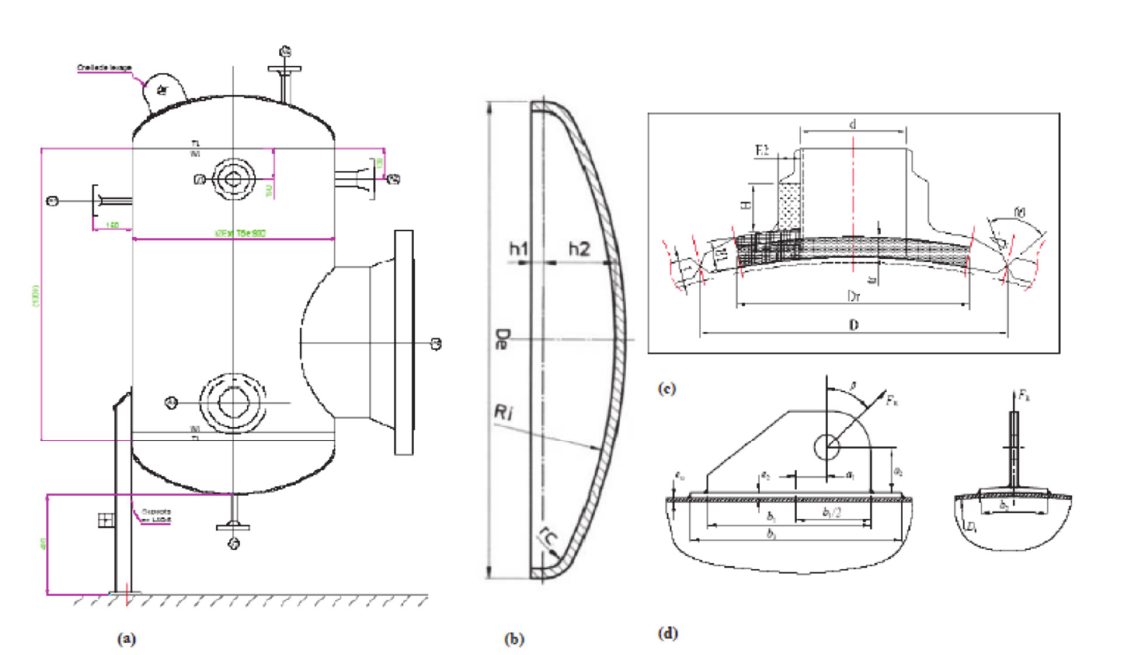
Figure 1: Illustration of pressure vessels elements.